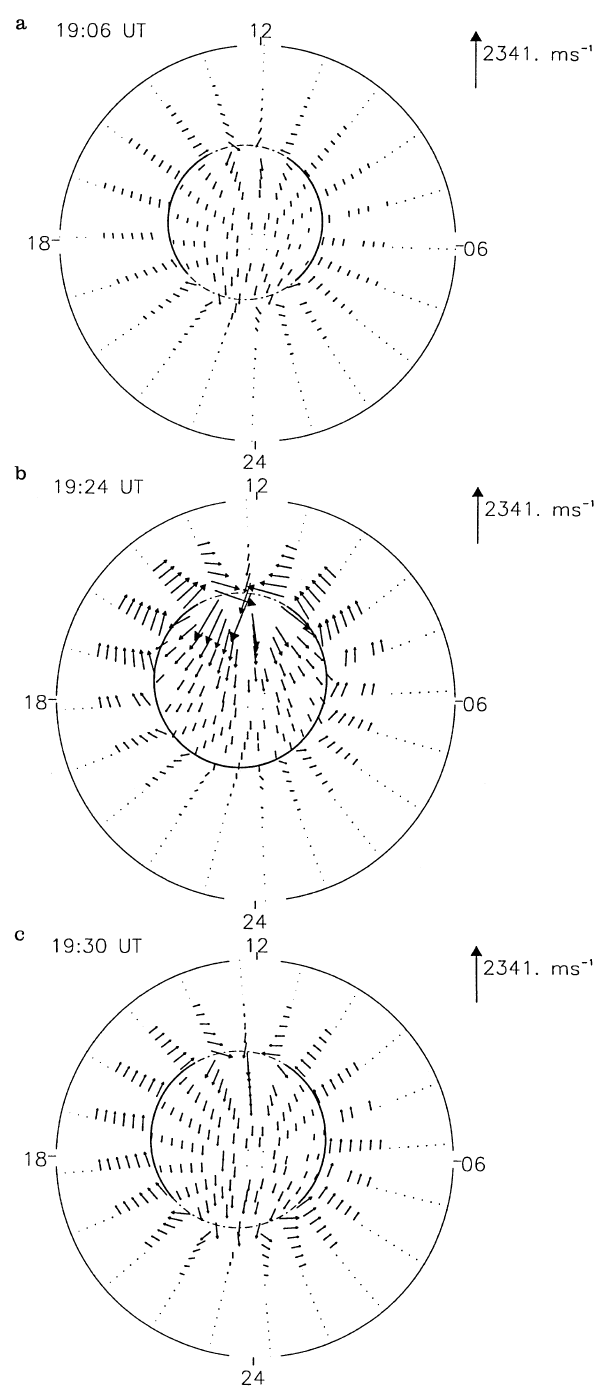
Fig. 1a–c. Input ion convection velocities at a 1906 UT, before the expansion event, b 1924 UT, during the event and c 1930 UT, after the event. The boundary of the plots is at 50 (cid:14) latitude, and vectors on each have the same scale. The solid thick circle shows the polar cap boundary. The dot-dashed line indicates the flux gaps through which plasma may enter and leave the